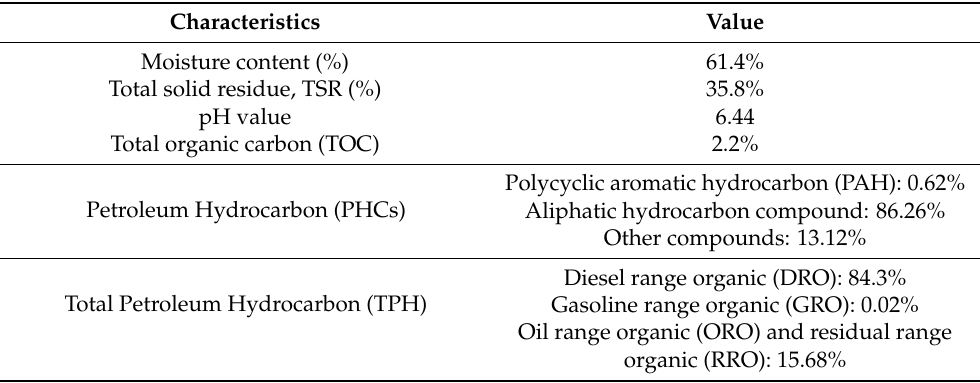
Table 4. Primary characterization of oily sludge.